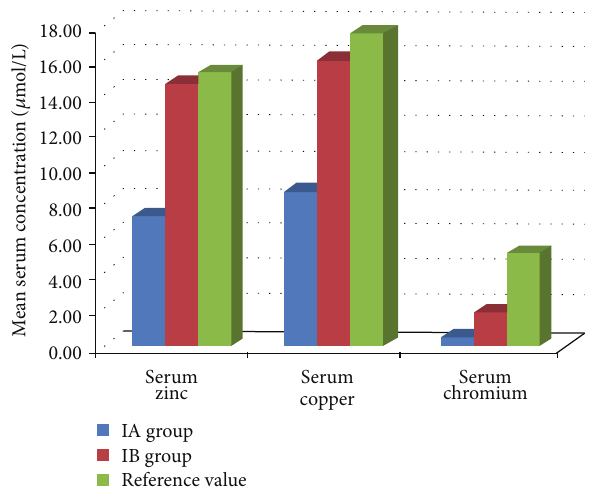
Figure 3: Serum concentrations of zinc, copper, and chromium among IA group and IB group of children with IDA.